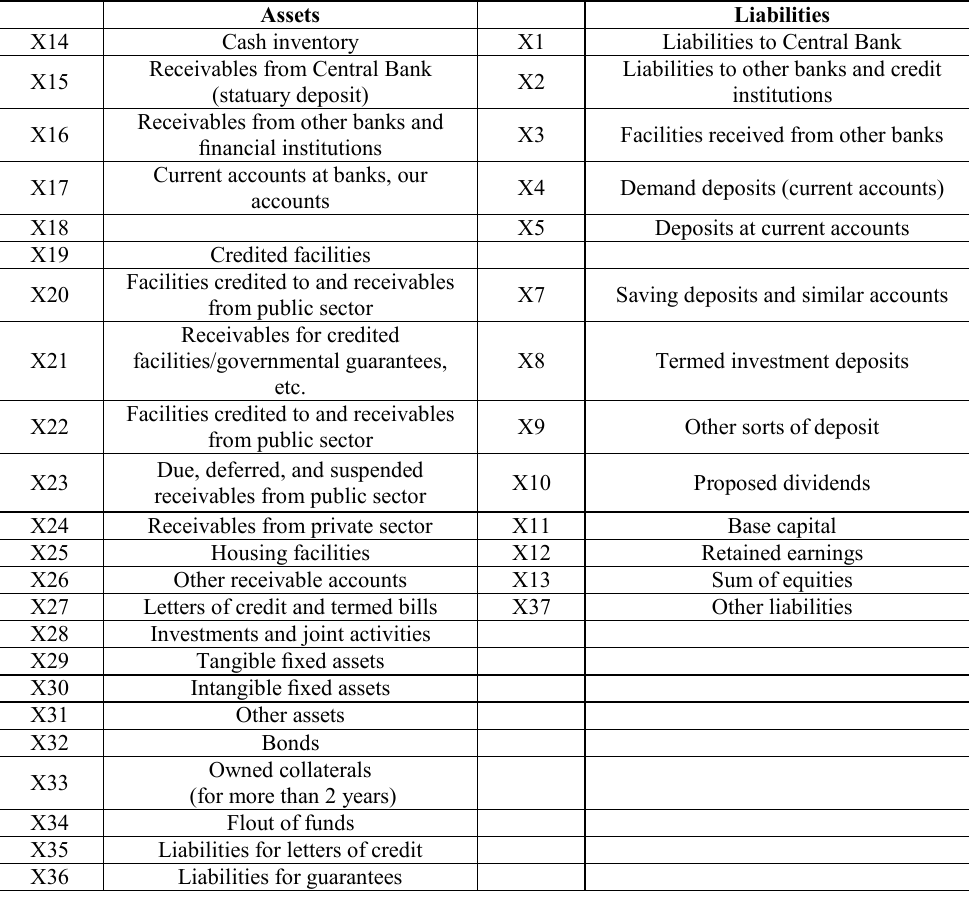
Table 2. Decision variables of the